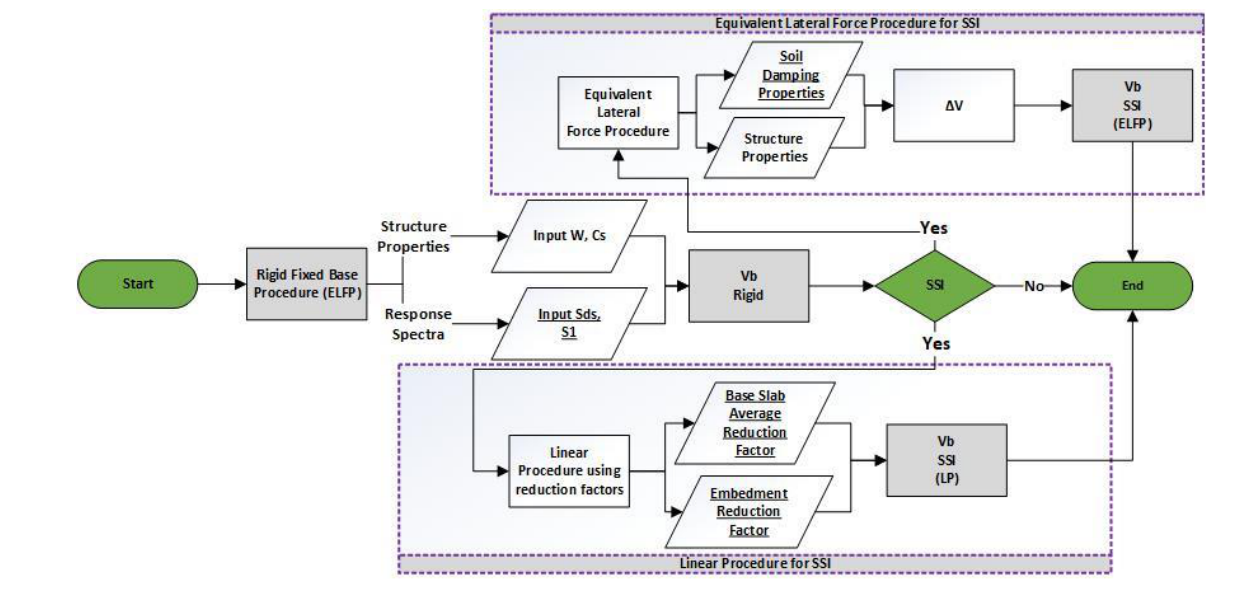
Figure 12. Flow chart of ASCE 7-16 procedure for SSI.